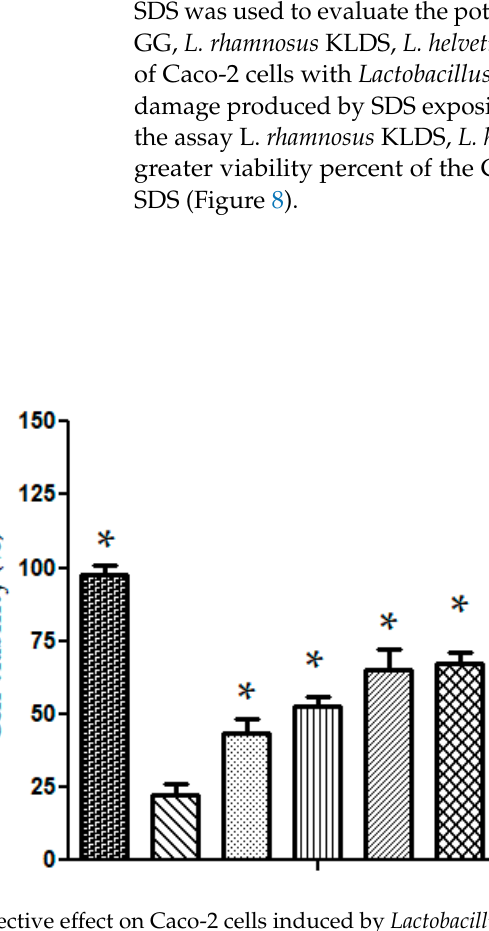
Figure 7. Immunomodulatory activity of Lactobacillus strains on the secretion of interleukin-8 (IL)-